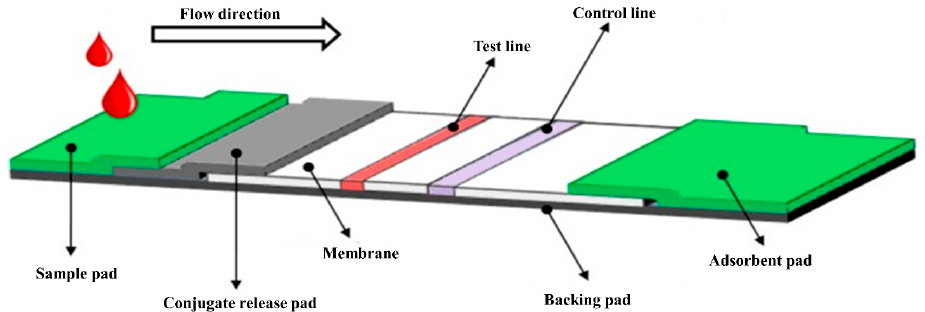
Figure 11. A typical structure of a lateral flow immunoassay test strip [129].